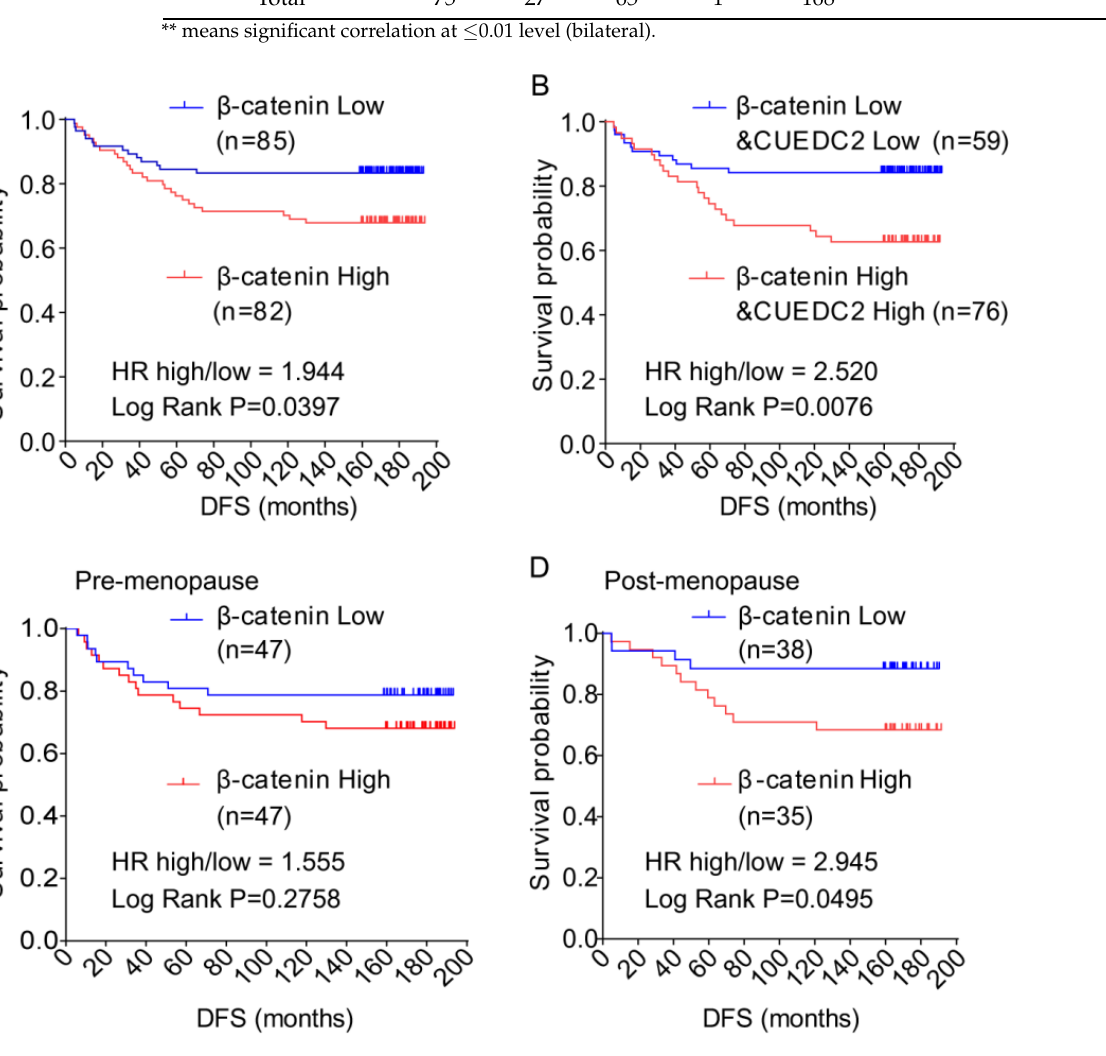
Figure 6. Disease-free survival (DFS) of TNBC patients with different levels of expression of β -catenin and β -catenin plus CUEDC2 in their tumor tissue. ( A , B ). K-M survival analysis on DFS of the TNBC patients with different levels of expression of β -catenin ( A ) and β -catenin plus CUEDC2 ( B ) in their tumor tissue. ( C , D ). K-M survival analysis on DFS of the post-menopause ( C ) and pre-menopause ( D ) patients with different levels of expression of β -catenin in their tumor tissue.